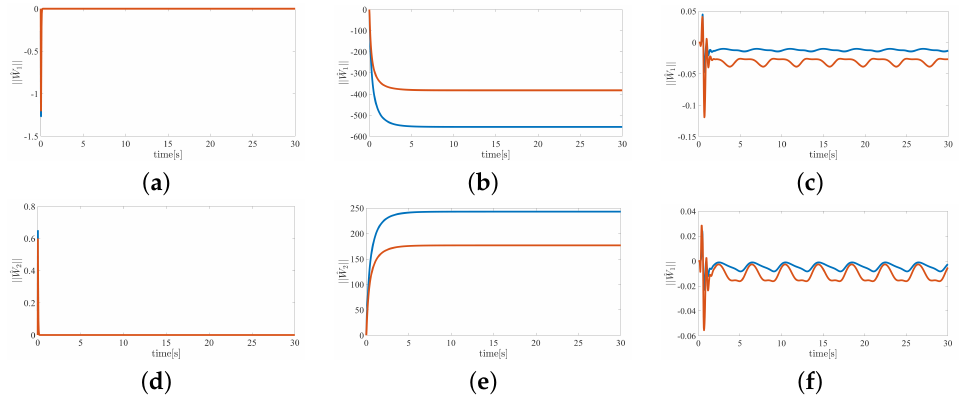
Figure 10. The norm of the weights for the two joints based on the CLIRBFNN, IRBFNN, and RBFNN. ( a – c ) show the norm of the weights for Joint 1. ( d – f ) show the norm of the weights for Joint 2.